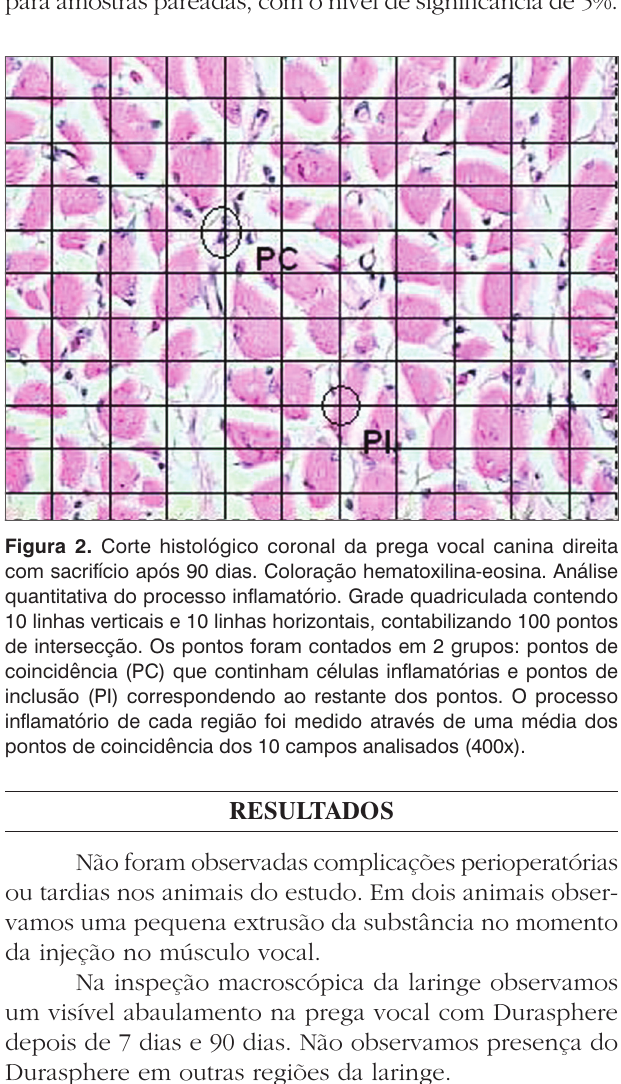
Figura 4. Corte histológico coronal da prega vocal canina direita (Du- rasphere) com sacrifício após 90 dias. Coloração hematoxilina-eosina. Observamos um infiltrado linfomononuclear leve no músculo vocal adjacente ao espaço vazio